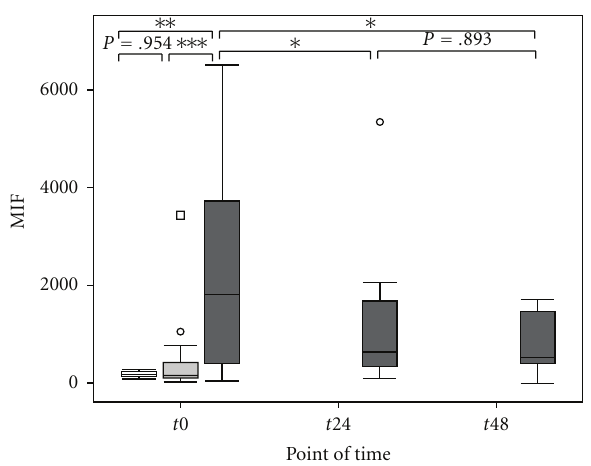
Figure 4: Strong correlation between TRX1 and MIF plasma levels in patients with severe sepsis or septic shock at the onset of sepsis syndrome. The scatter plot visualizes concentrations of Macrophage Migration Inhibitory Factor (MIF; (pg/ml)) as well as accompanying concentrations of Thioredoxin-1 (TRX1; (ng/ml)) from patients with severe sepsis or septic shock at the onset of sepsis syndrome ( t 0) (“Sepsis,” n = 15, black circles). Abbreviations: MIF, Macrophage Migration Inhibitory Factor; TRX1,